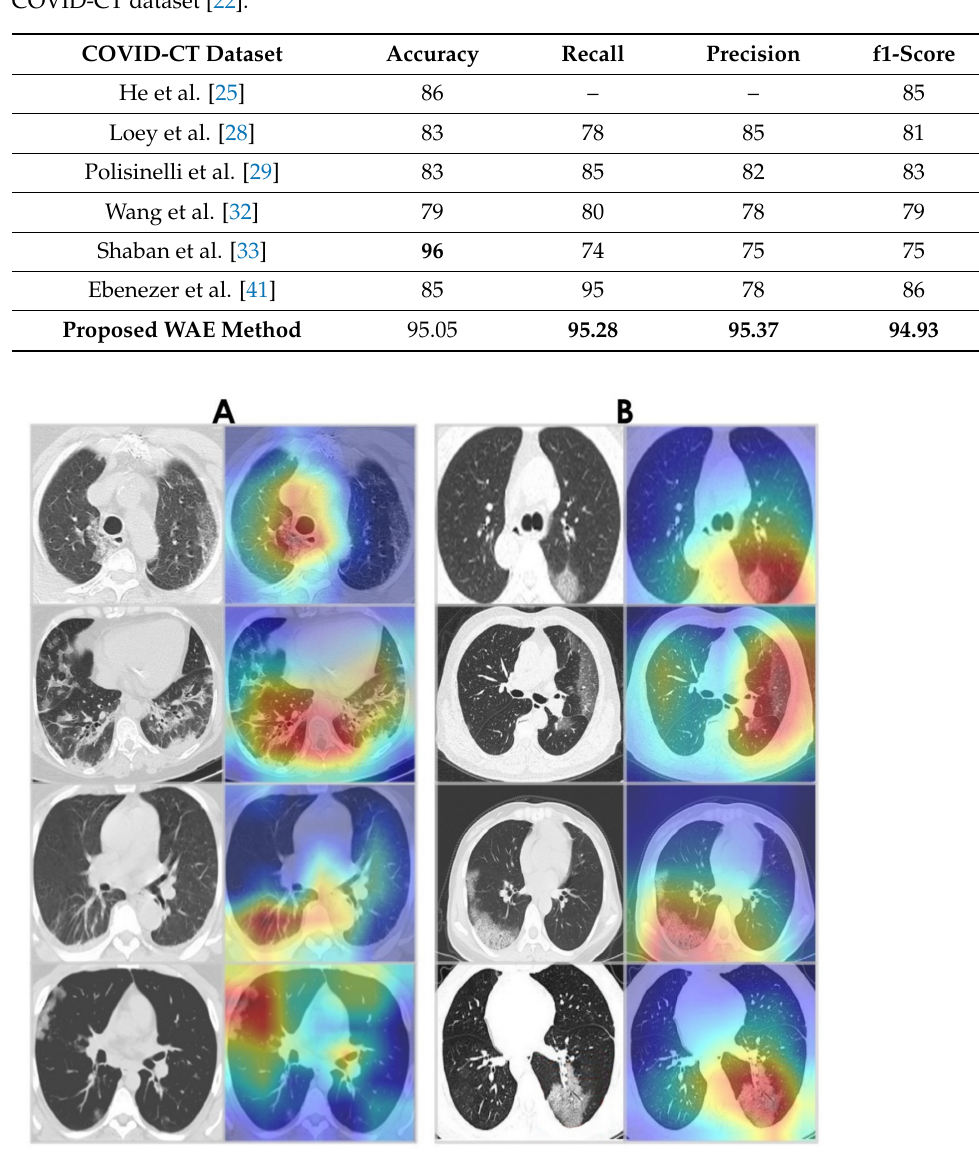
Figure 19. Grad-CAM visualizations. ( A ) Sample CT images from the SARS-CoV-2 CT-scan dataset [42]. ( B ) Sample CT images from the COVID-CT dataset